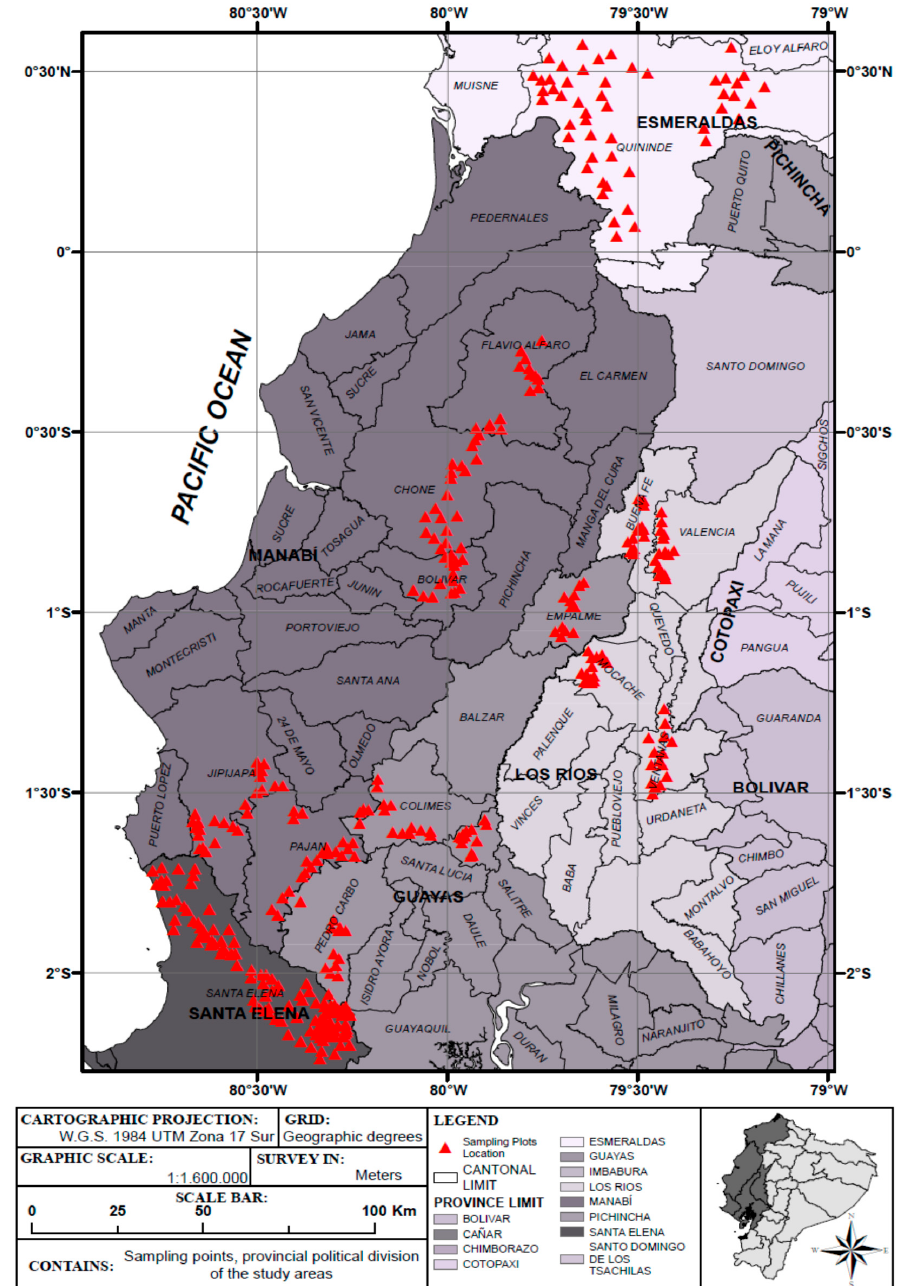
Figure 1. Geographic distribution of silvopastoral systems (SPS) and location of sampling plots for the use of teak as living fences in the coastal lowlands of Ecuador.